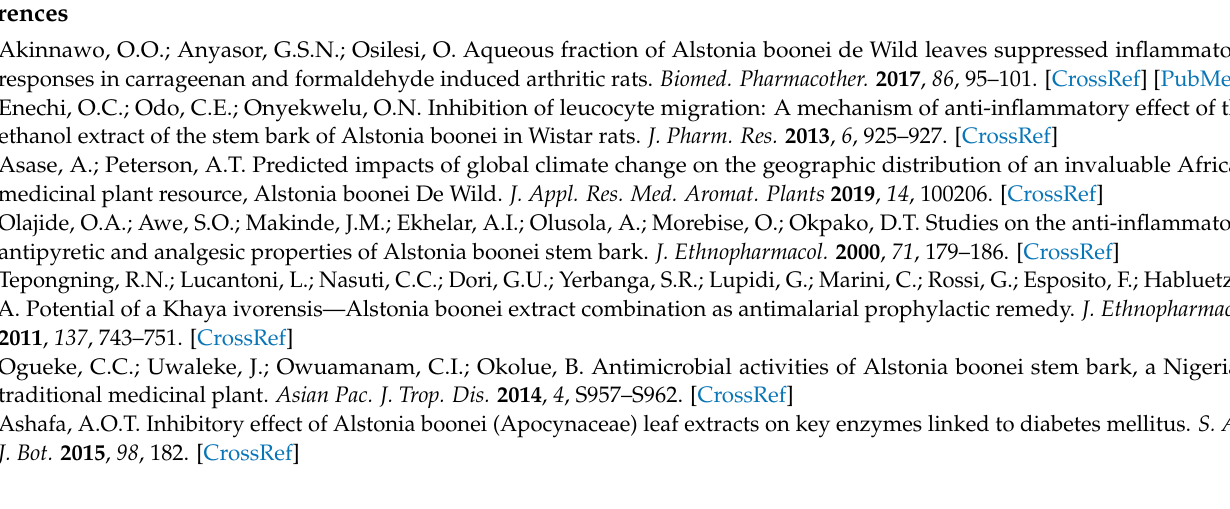
Figure S9. Total ion chromatogram of Alstonia boonei stem bark maceration-EA in positive mode; Figure S10. Total ion chromatogram of Alstonia boonei stem bark maceration-EA in negative mode; Figure S11. Total ion chromatogram of Alstonia boonei stem bark maceration-MeOH in positive mode; Figure S12. Total ion chromatogram of Alstonia boonei stem bark maceration-MeOH in negative